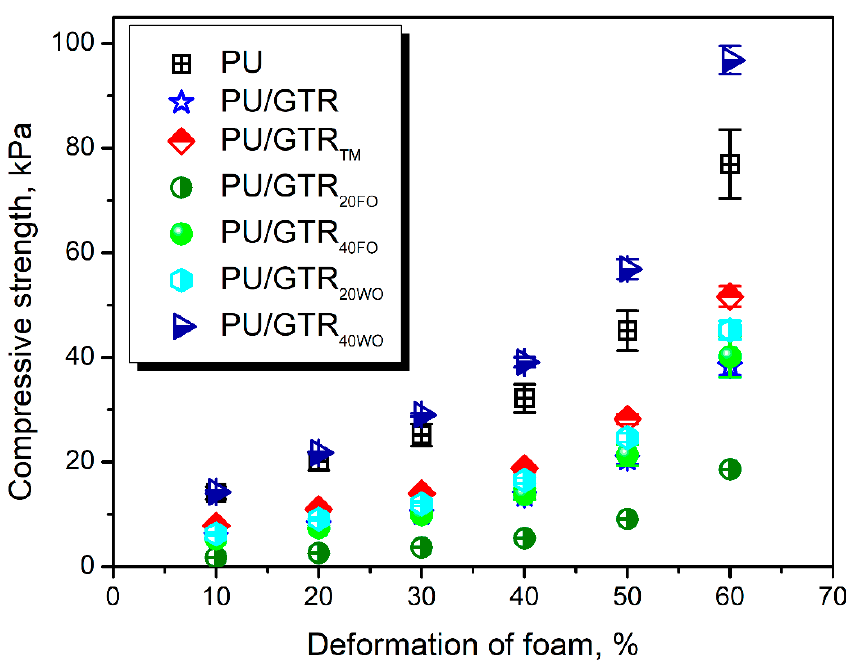
Figure 8. Compressive strength of prepared polyurethane foams.